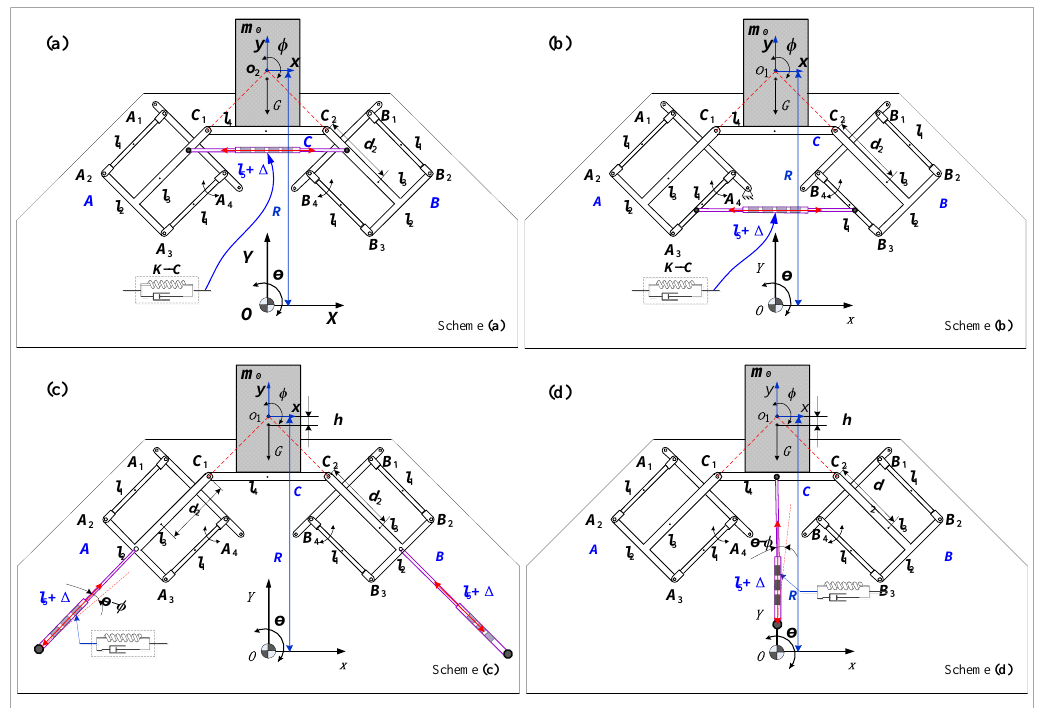
Figure 5. Four linear spring configuration schemes. ( a ) Spring-damping connects two main branches; ( b ) Spring-damping connects two parallelograms; ( c ) Spring-damping connects parallelogram and base platform; ( d ) Spring-damping connects vibration isolation platform and base platform.